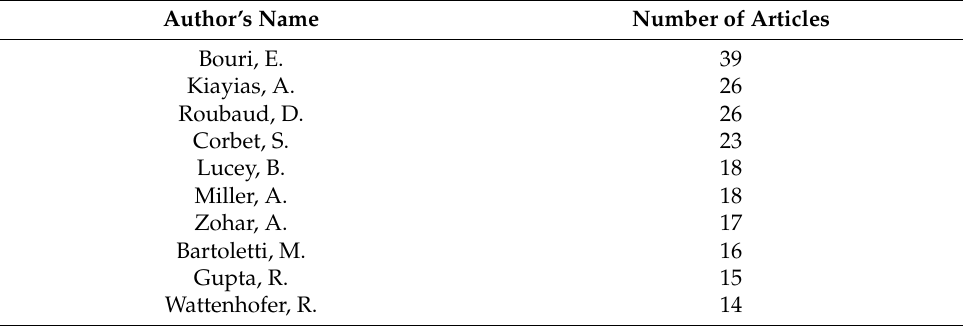
Table 7. Most productive authors of Bitcoin studies.